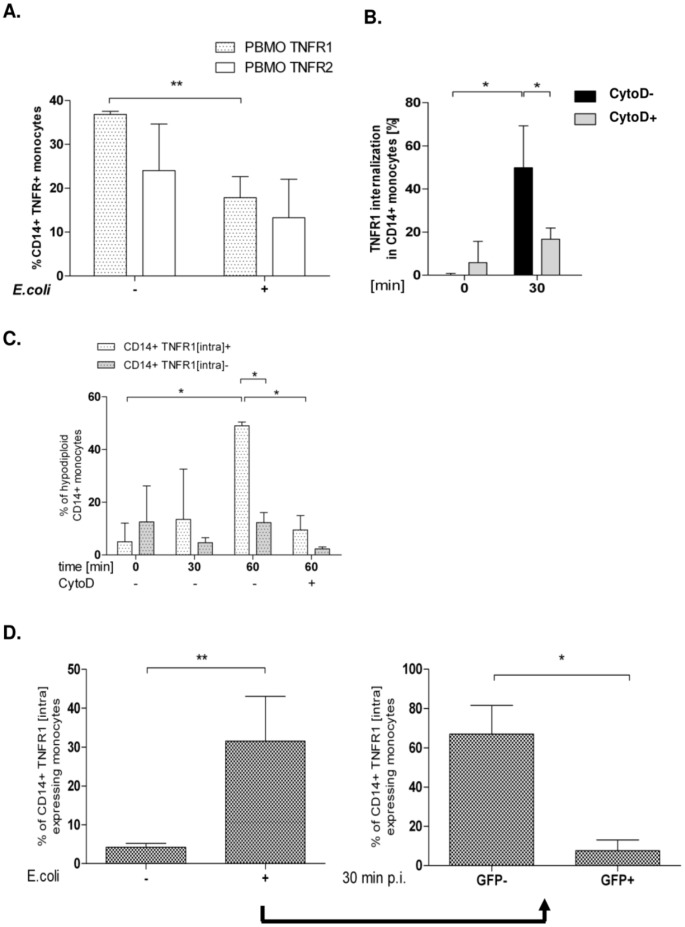
TNFR1 is internalized after incubation with TNF-α and after infection with E. coli and leads to monocyte apoptosis.Monocytes were infected with E.coli-GFP for one hour and free bacteria were removed. 4 hours p.i. TNFR1 and -2 expression were analyzed by FACS (A; n = 9, **p<0.01). Analysis of TNFR1 internalization following TNF-α administration after 30 minutes; one group received CytoD (B; n = 7, p<0.05). In the described experimental setup, monocyte apoptosis was analyzed via Vybrant DNA-content and distinguished by internalization of TNFR1 (C, * p<0.05, ** = p<0.001). One group was cultivated with CytoD. TNFR1 internalization 30 min p.i. Internalization was quantified for GFP-negative and –positive monocytes (D; n = 5,* p<0.05, ** p<0.001.